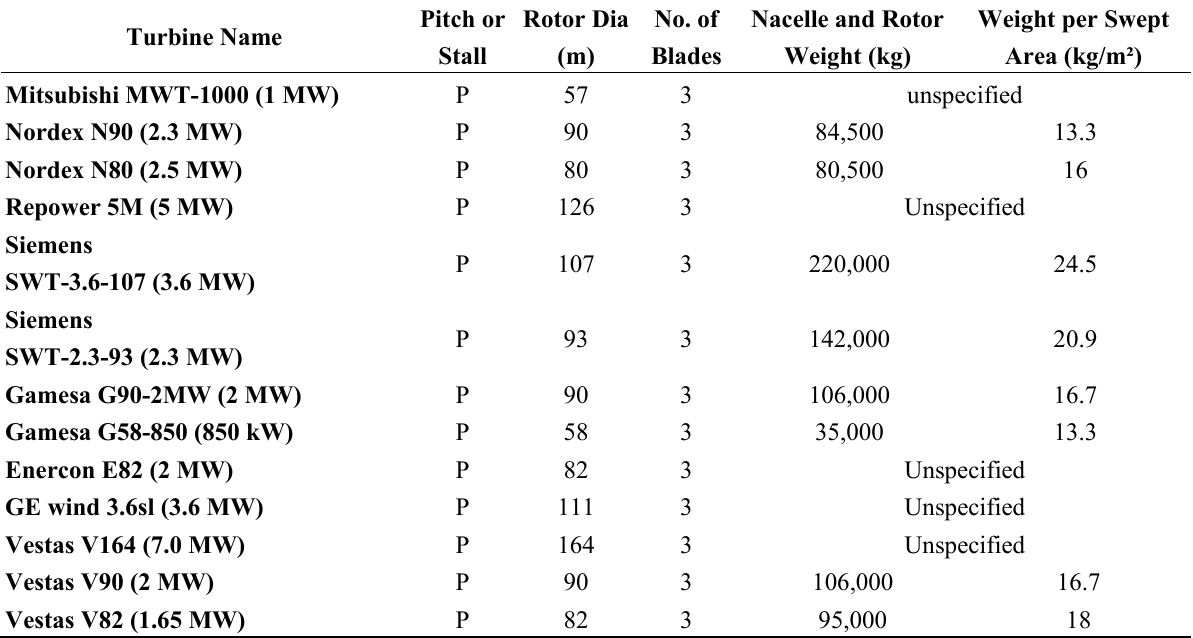
Table 4. A selection of turbine size and weight configurations.